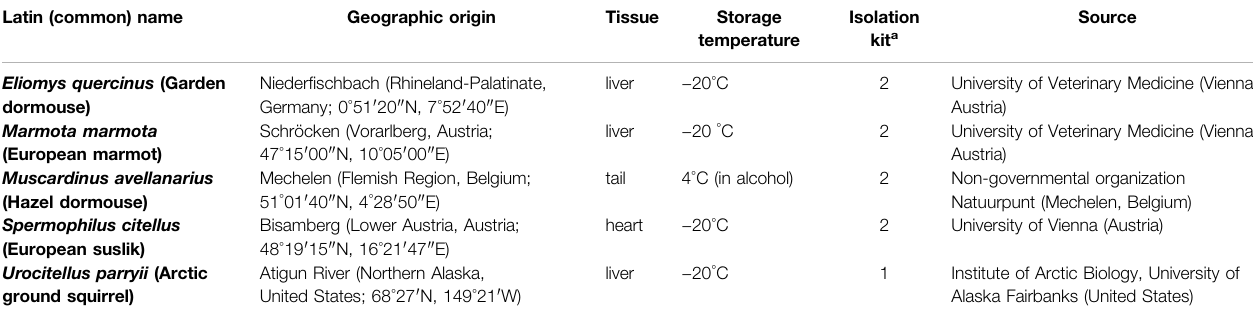
TABLE 1 | Target species of the long-range PCR assay amplifying vertebrate mtDNA with a pair of back-to-back primers.